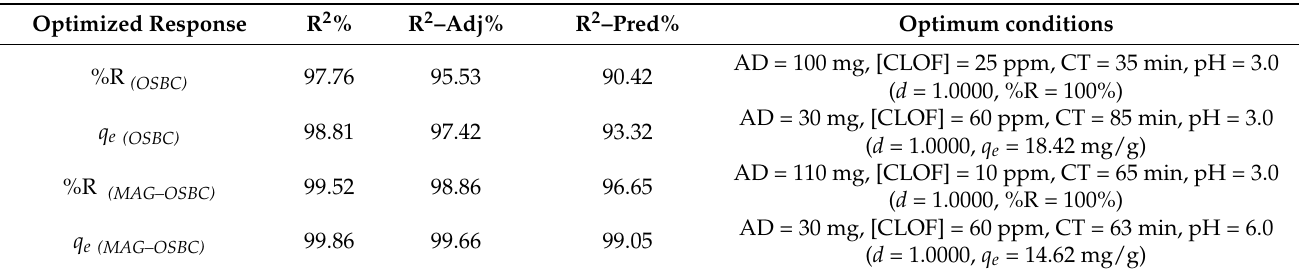
Table 5. Summary of the regression models, Equations